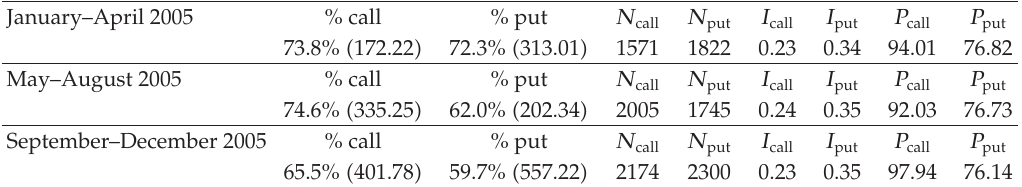
Table 1: S & P 500 option prices: in the money options (cid:2) year 2005 (cid:3) . These results were obtained using the estimates (cid:2) 4.2 (cid:3) and (cid:2) 4.3 (cid:3) .